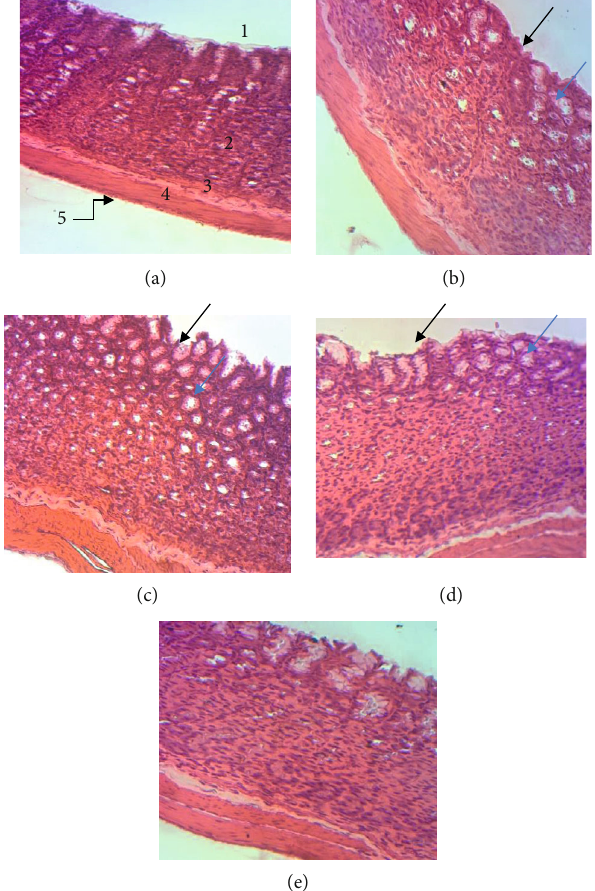
Figure 3: Histological study of ethanol-induced gastric damage in rats (H&E: × 400): (a) normal control rat: no injuries in the gastric mucosa are seen; (b) control 1 and (c) control 2: there is destruction of epithelium surface and edema; (d) sucralfate 100 mg/kg: the gastric wall appears with small destruction of epithelium and edema; (e) extract 500mg/kg): there is complete cicatrization of ulcerated